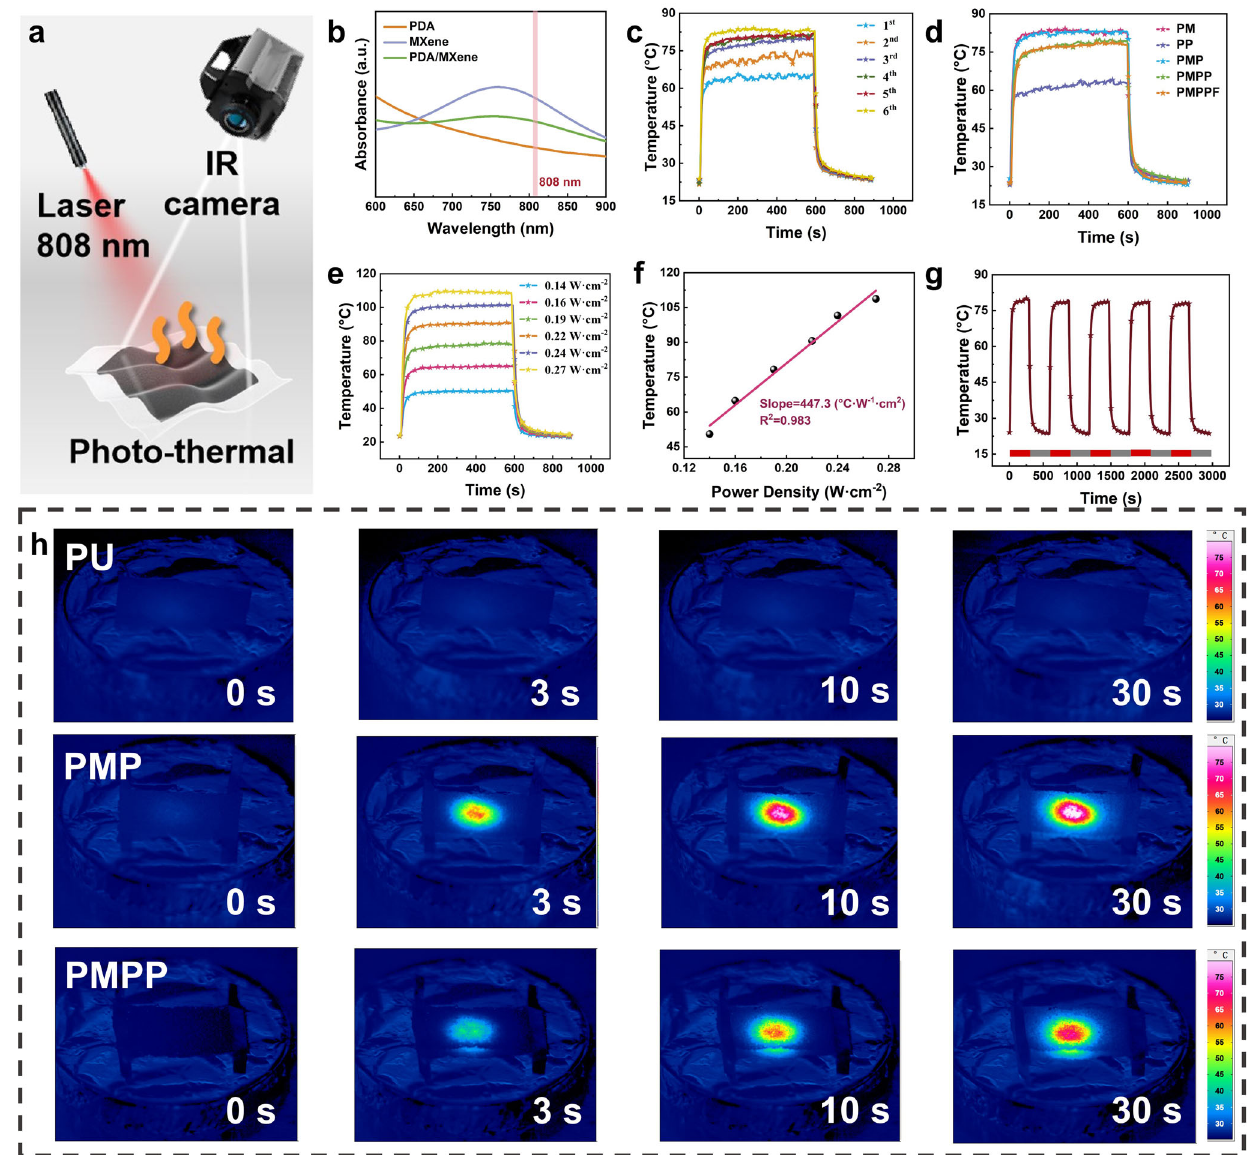
Fig. 6 Photothermal heating performance of PMPPF electrical device. a Schematic diagram of simulated photo-thermal test model. (Laser height = 10 cm) b Ultraviolet-vis-NIR absorbance of PDA, MXene and PDA/MXene nanocomposites aqueous dispersions. c The temperature- time curve of PM prepared with different MXene coating times. d The temperature-time curve of PP, PM, PMP, PMPP, and PMPPF. e The temperature-time curve of PMPPF (lower surface) under different power densities and f corresponding linear fi tting curve of the relationship between equilibrium temperature and NIR laser power densities. g Temperature curves for 5 laser on/off cycles. h IR images of PU, PMP, and PMPP (Power density = 0.19 W·cm − 2